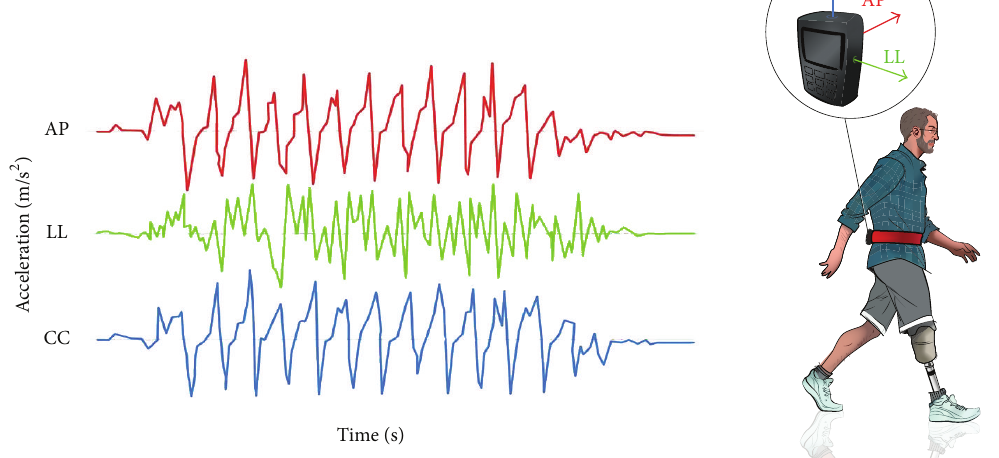
Figure 2: The Upright Gait Stability assessment during walking. The triaxial accelerometer placed on the back area (L2-L3) of each subject allows expressing the acceleration’s signals along the three anatomical axes: anteroposterior (AP, red line), laterolateral (LL, green line), and craniocaudal (CC, blue